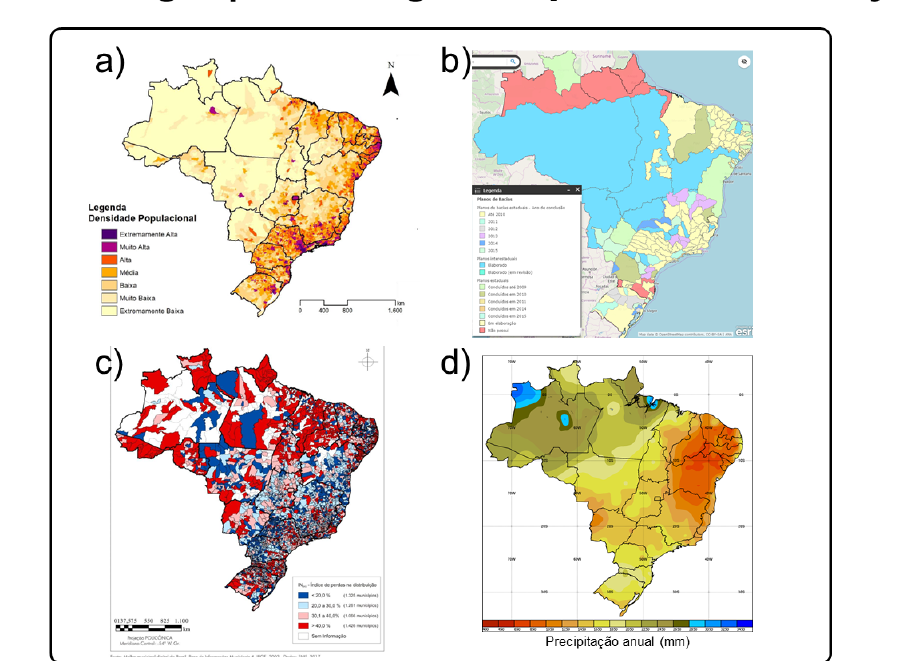
Figure A22. Package of maps used in the fifth training for mapping climate risk associated with water scarcity. The maps illustrate (a) pop- ulation density (MMA, 2017), (b) stage of implementation of the water resources planning (Planos de Recursos Hídricos, 2020), (c) water distribution loss index (Brasil, 2017), and (d) annual rainfall (Normais climatológicas do Brasil, 2020).